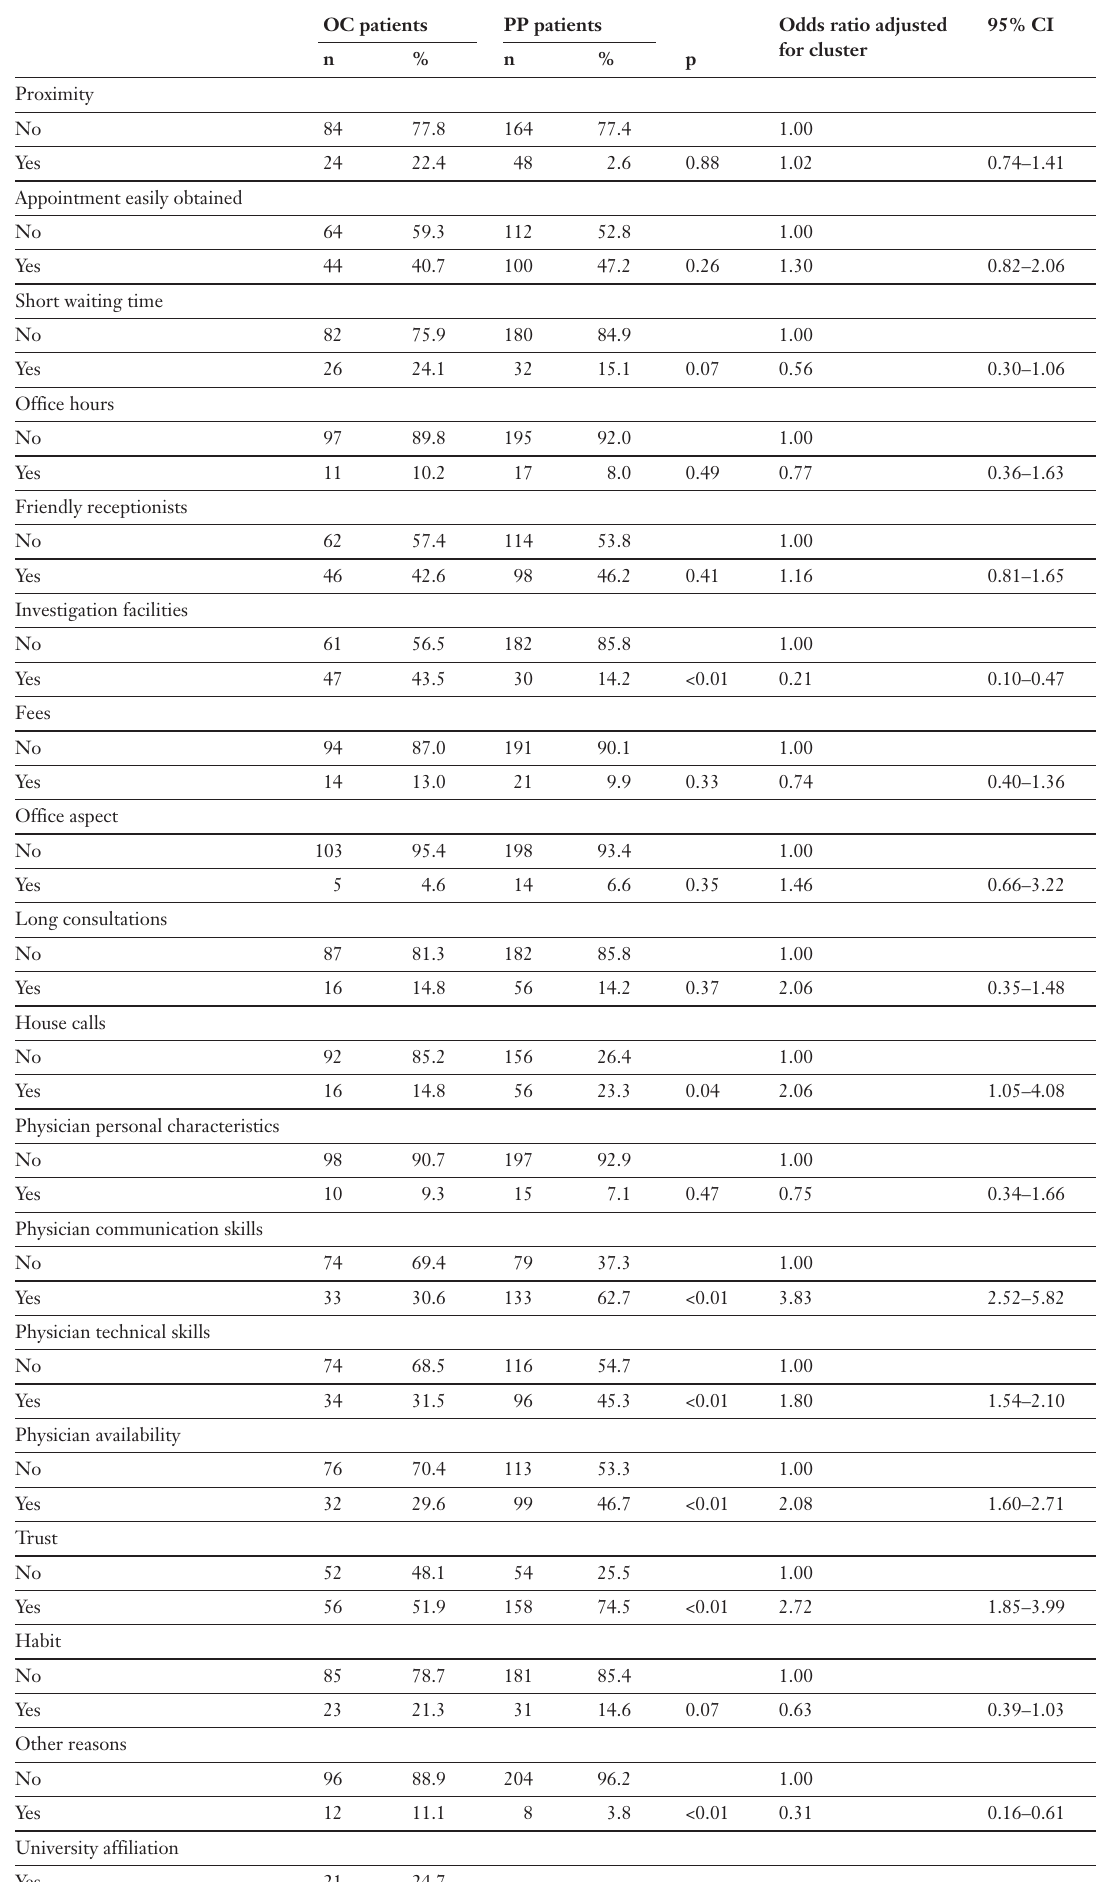
Reasons for remain- ing at the same prac- tice for university medical outpatient clinic (OC) patients and private practice (PP)